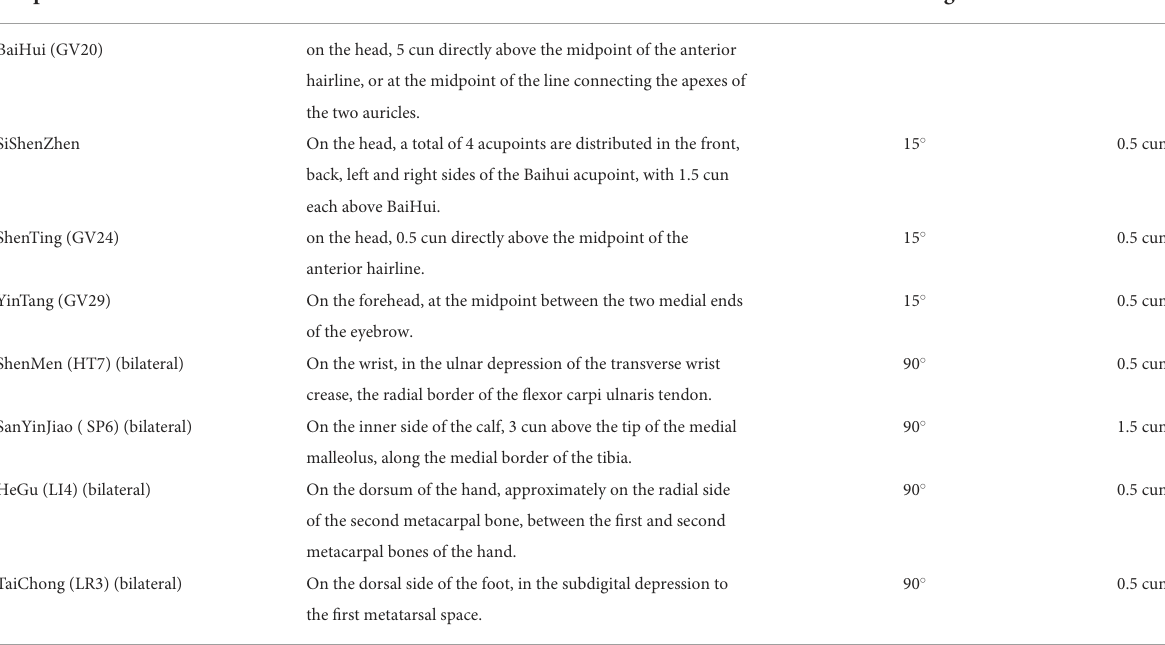
TABLE 2 Specific acupoint location and angle